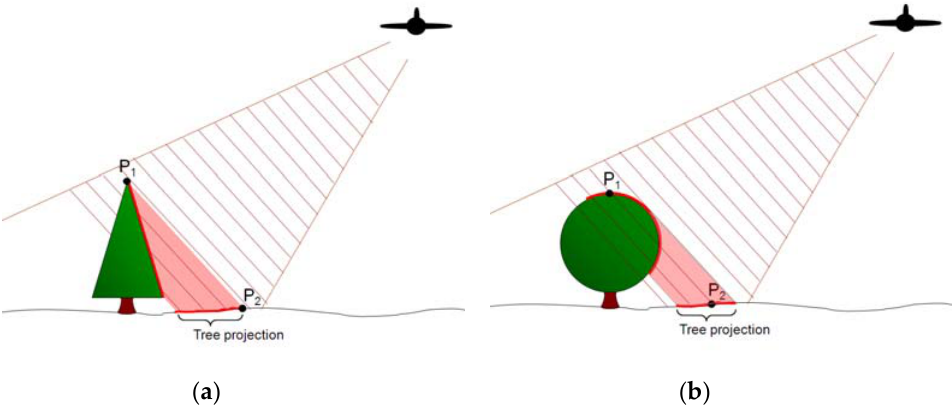
Figure 2. Layover effect on two trees of differing geometry observed at a similar incidence angle near 45°. The radar images backscatter at fixed slant ranges, schematically illustrated with the slanted lines. Two tree shapes are shown: ( a ) a typically ‐ shaped conifer; ( b ) a broadleaf tree with a spherical canopy. Note that the cross ‐ track location of the leading edge of the tree canopy in the image (point P 2 ) depends on both the tree height P 1 as well as the tree shape. When measuring the height of isolated trees, both shape and height must be considered. Analysis of case ( b ) is complicated by variations in the density of the canopy.